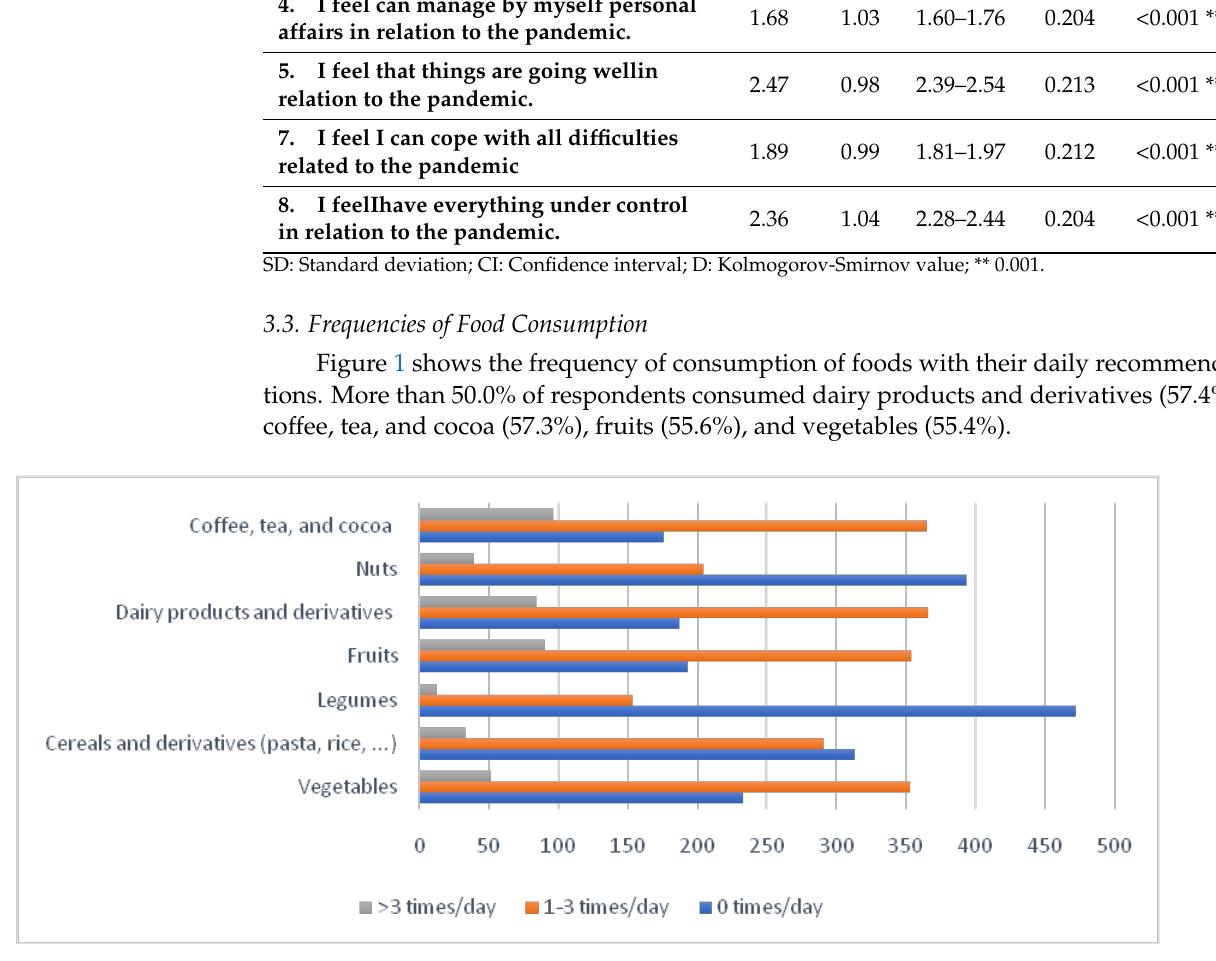
Figure 1. Frequency of consumption. Foods with daily recommendations. Legumes and nuts were the least frequently consumed foods on a daily basis, with 74.1% and 61.8%,